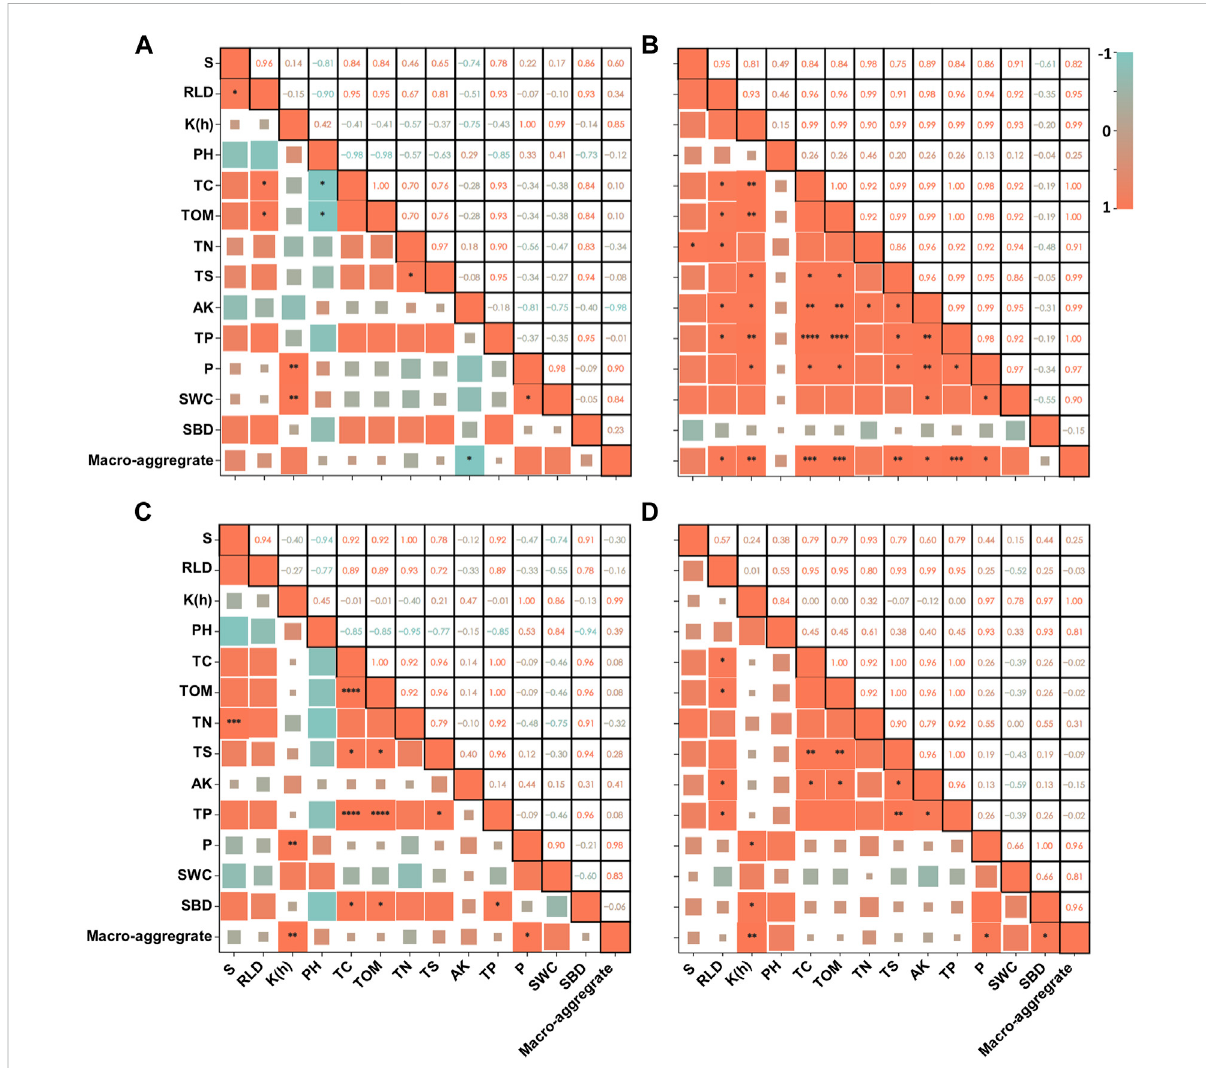
FIGURE 7 Correlation between RLD, water uptake index, soil hydraulic conductivity, and soil physiochemical properties at four experimental sites (a – d). Soil physiochemical properties indicators include soil PH (PH), total carbon (TC), soil hydraulic conductivity [K( θ )], total organic matter (TOM), total nitrogen (TN), total salt (TS), soil available potassium (SAK), total phosphorus (TP), porosity (P), soil water content (SWC), soil bulk density (SBD), and the ratio of the number of macroaggregates (diameter > 0.25 mm) to the total number of aggregates (Macro-aggregate). (Note: * means p